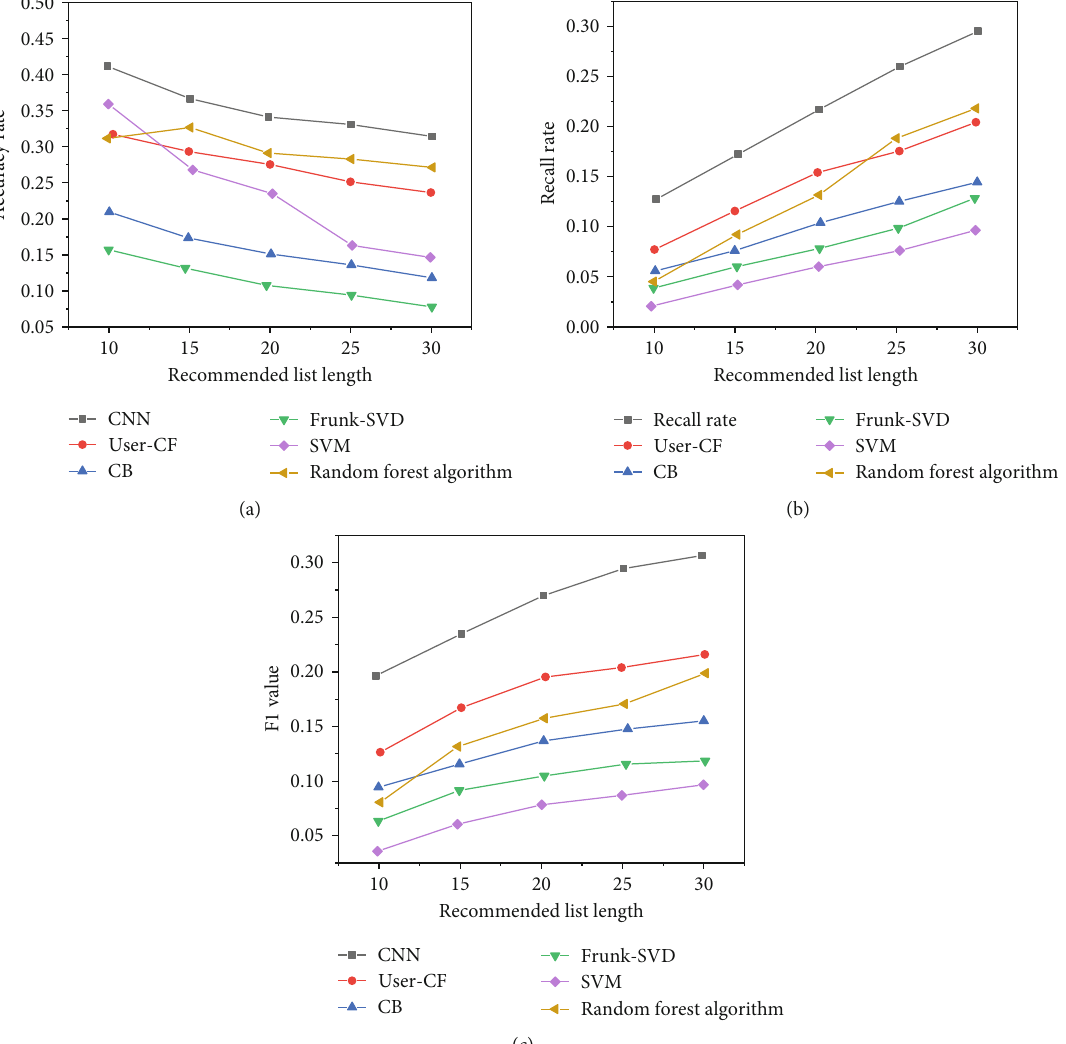
Figure 18: Comparison of di ff erent recommendation algorithm models ((a) accuracy; (b) recall; (c) F 1